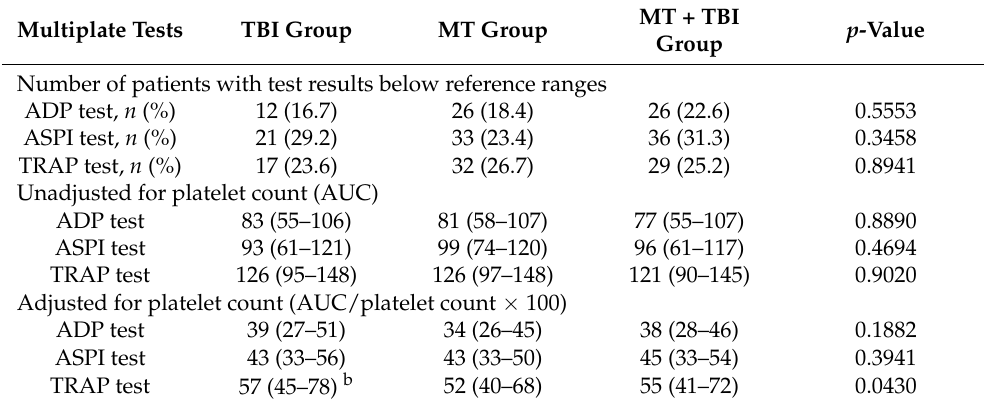
Table 3. Multiplate test results upon ER admission adjusted and unadjusted for platelet count.